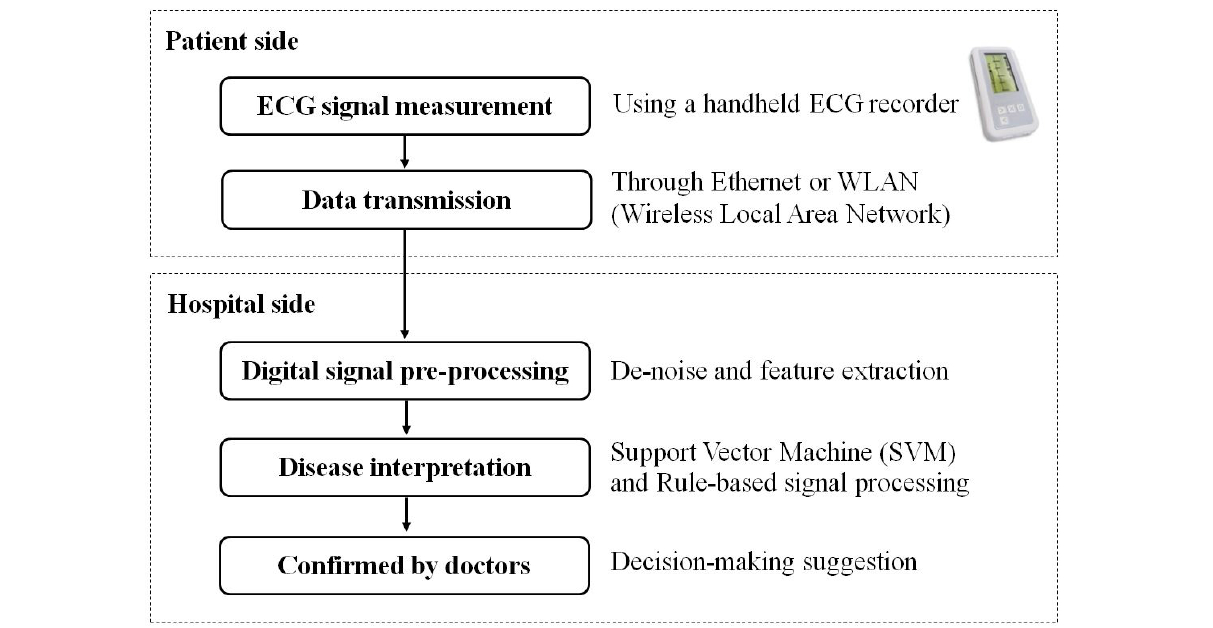
Figure 1. Flowchart of ECG signal analysis in the telesurveillance system. Patients use the handheld recorder to obtain the single-lead ECG signal, which will be automatically transmitted to the Telehealth Center at the NTUH for monitoring.